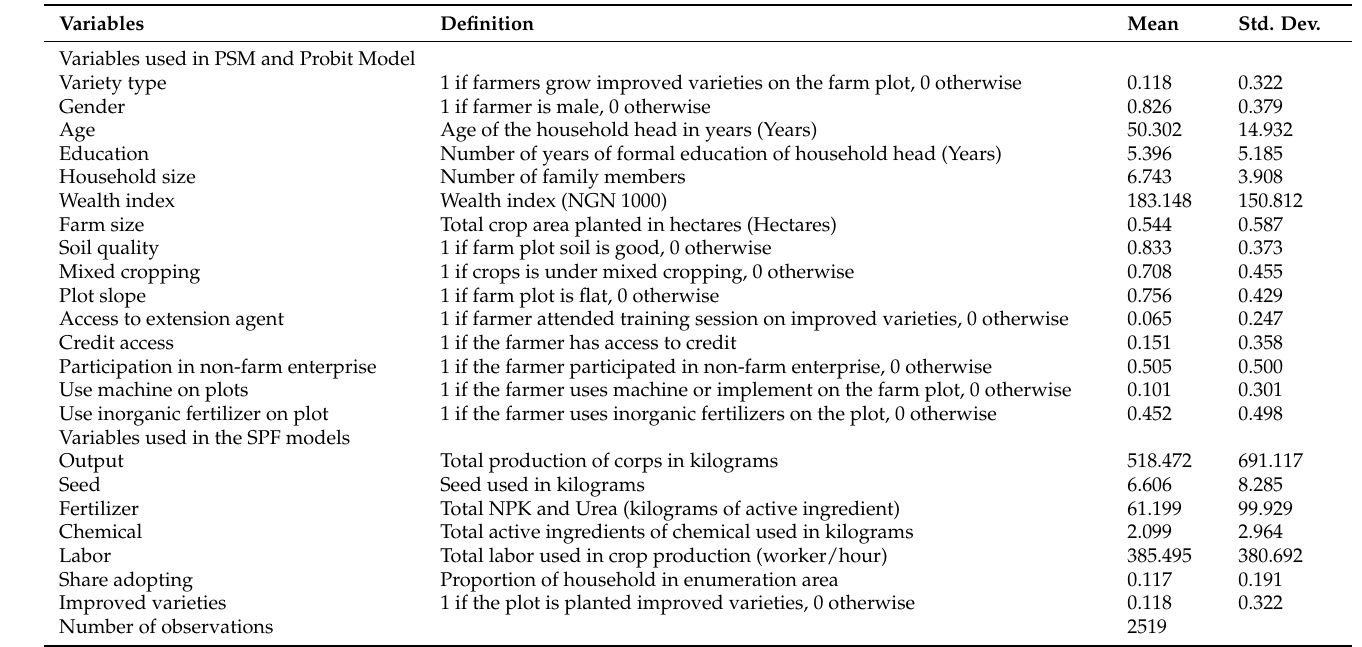
Table 1. Description and summary statistics of variables used in the